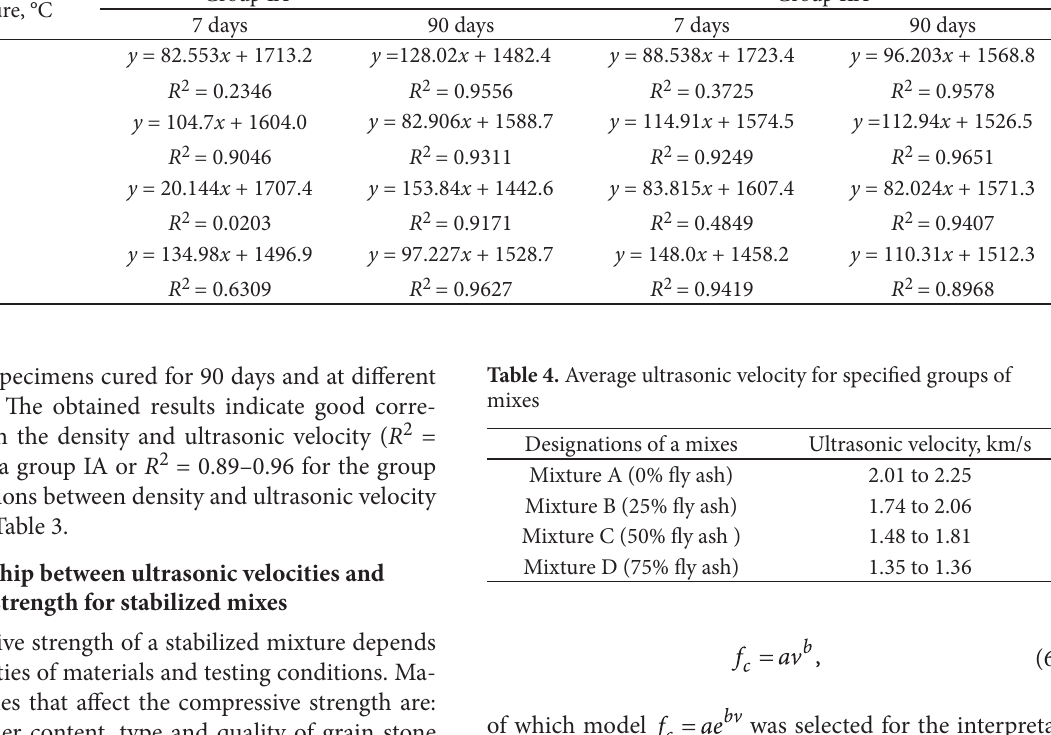
Table 3. Correlations between density and ultrasonic velocity Temperature, �C